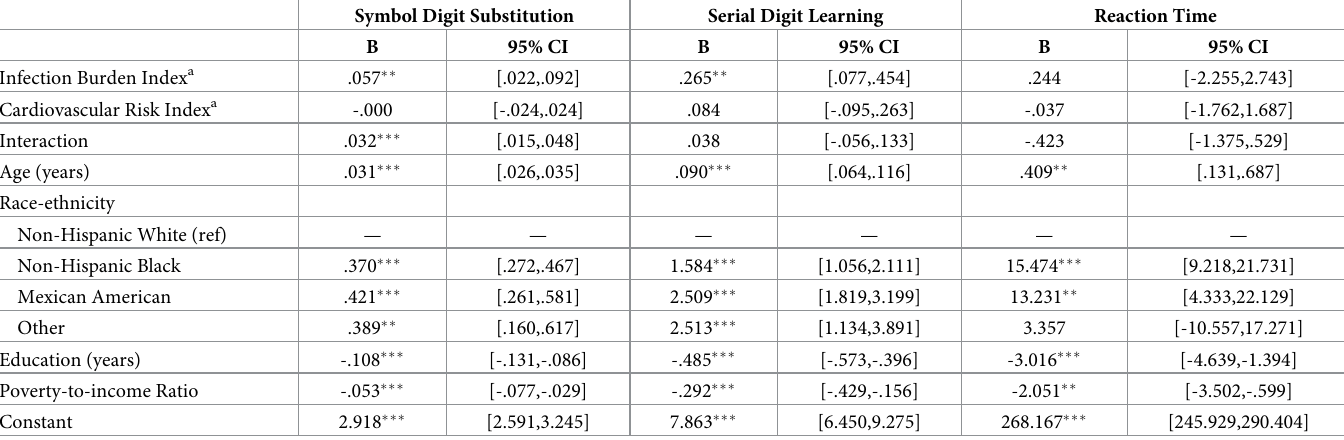
Table 3. Interaction effects between an infection-burden index and cardiovascular-risk index and associations with cognitive function in female U.S. adults aged 20 to 59 years. Symbol Digit